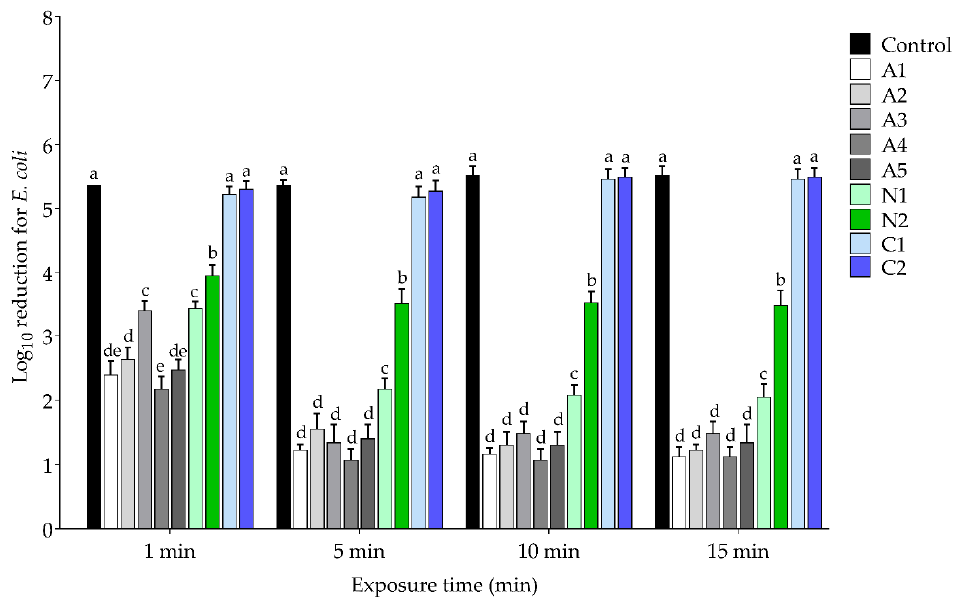
Figure 5. Log 10 reduction of E. coli with different exposure times to a mixture of CHG and selected lubricating gels. Data represent the mean ± SD of three independent experiments, and different letters (a–e) indicate a significant difference ( p < 0.05).